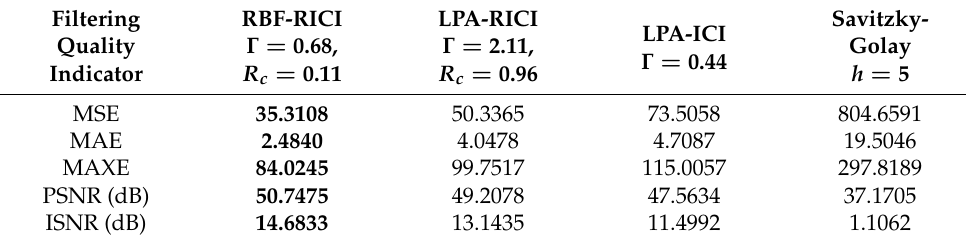
Table 38. Sing signal (SNR = 10 dB)—Filtering results.